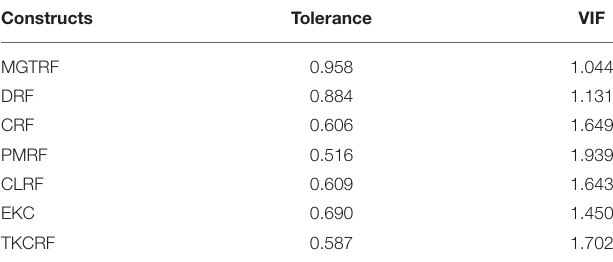
TABLE 11 | Multicollinearity.